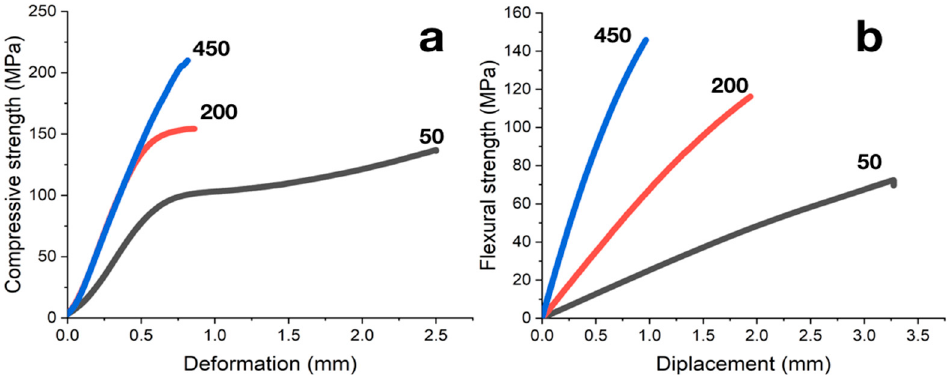
Figure 7. ( a ) Strain–stress diagrams from compression tests of carbonized samples; filling degree in PHR is indicated near curves. ( b ) Load-deflection diagrams from flexural tests of carbonized samples; filling degree in PHR indicated near curves.